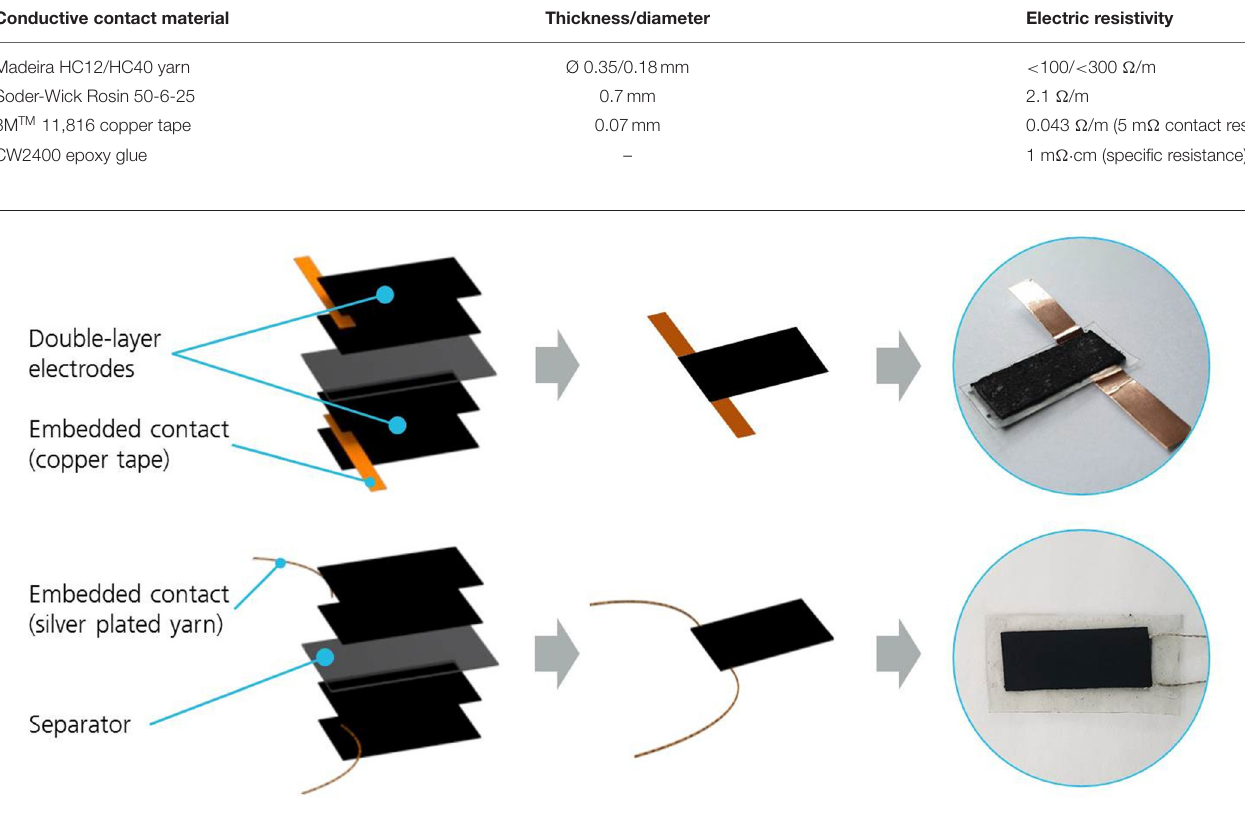
FIGURE 3 | Concept and implementation of IEAP actuator and sensor assembly by embedding conductive contact materials into